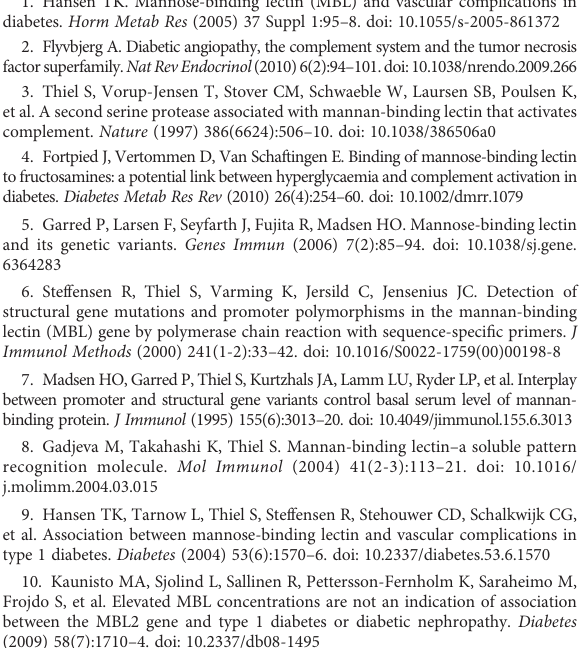
SUPPLEMENTARY TABLE 1 Baseline characteristics in participants included and not included in the 12 years follow-up